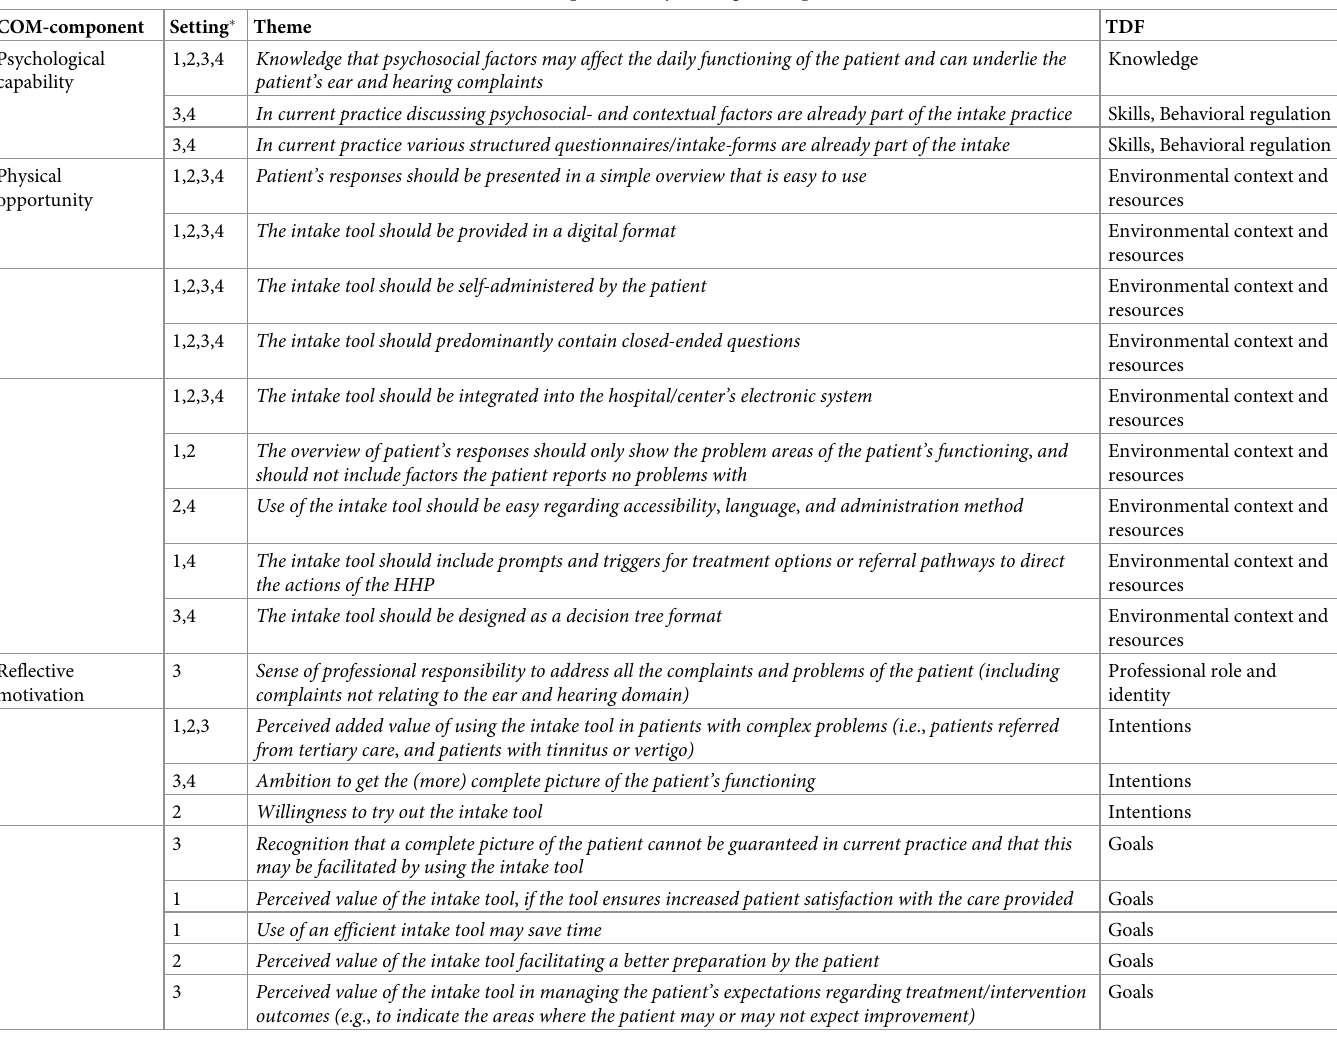
Table 4. Identified enablers of the use of the ICF-based intake tool as perceived by hearing health professionals. COM-component Setting � Theme Psychological